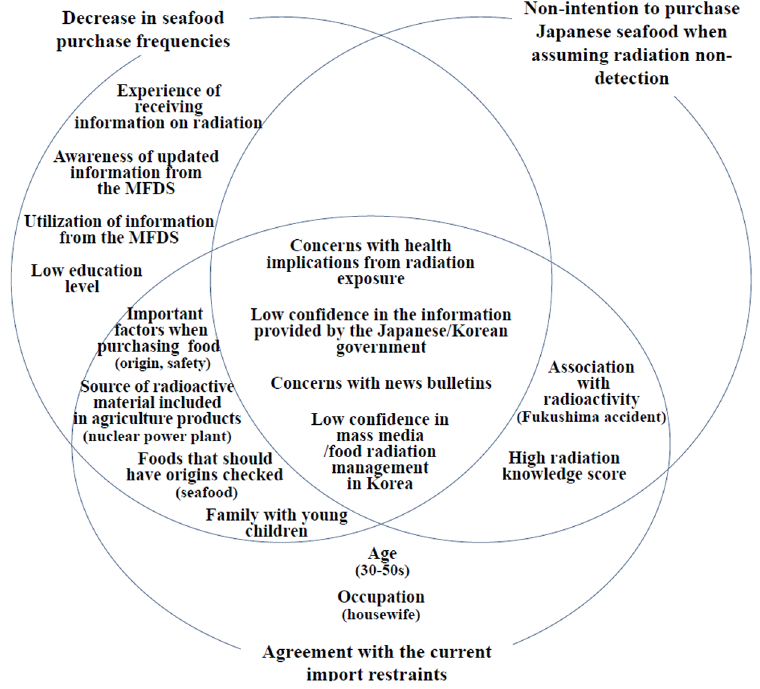
Fig 4. Factors associated with the purchase tendencies, intentions to purchase Japanese seafood, and agreementwith the current import restraints after the Fukushima nuclear power plant